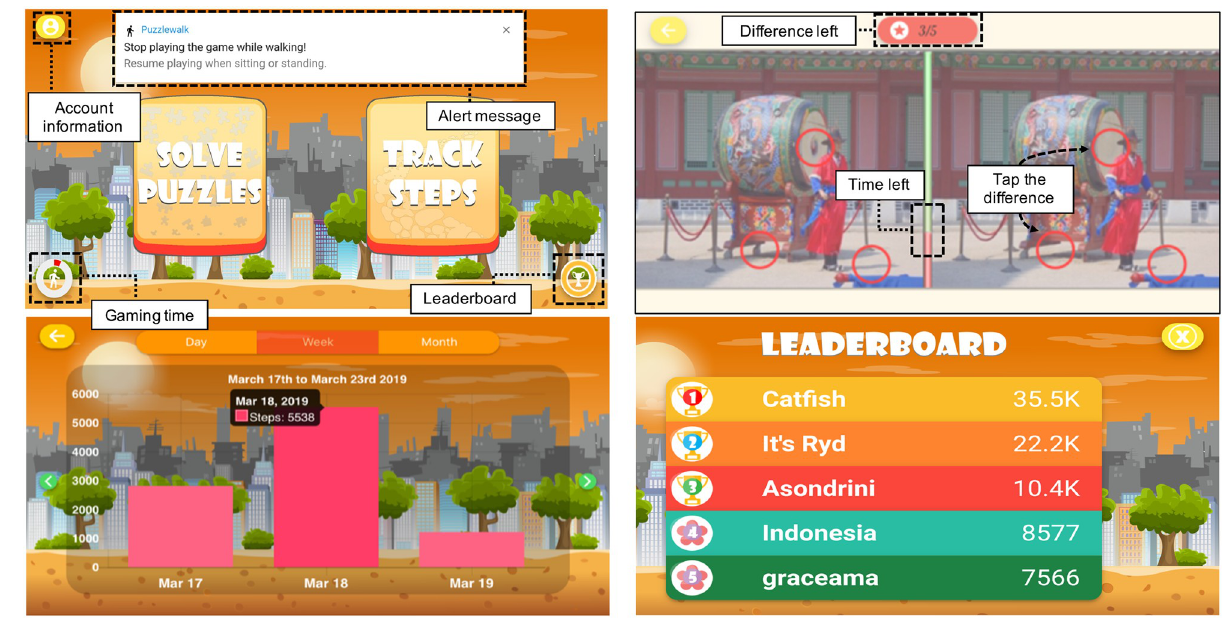
Fig 4. Screenshots of the functional